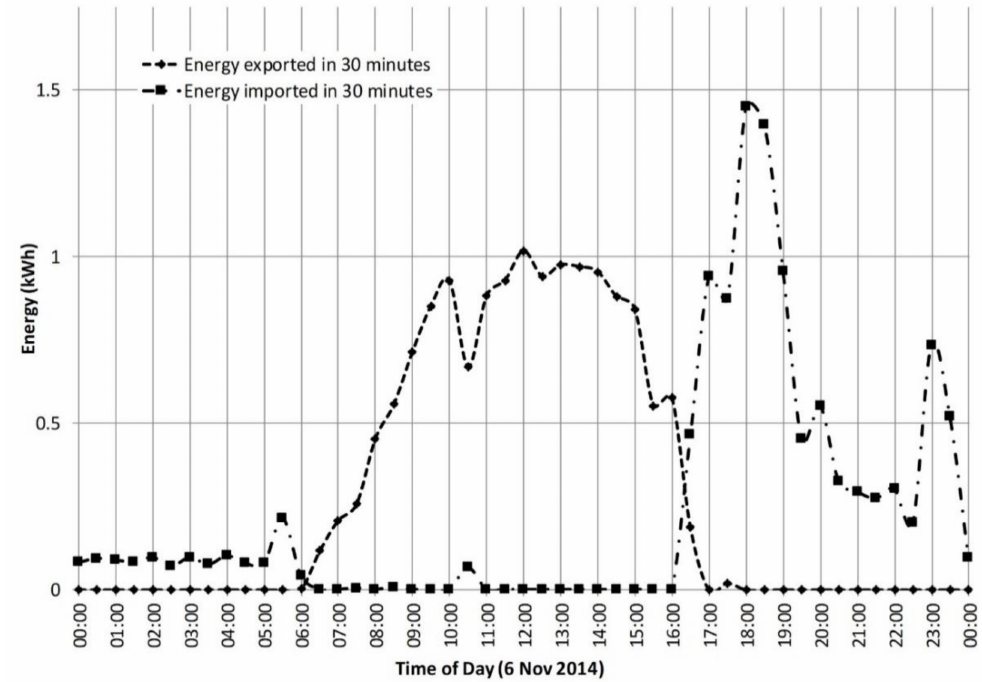
Figure 1. The mismatch of exported and imported